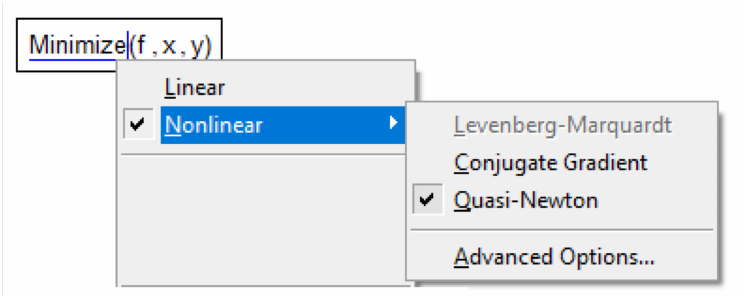
Figure 22. A snapshot of the instructions of the program in Mathcad 15 for choosing a numerical